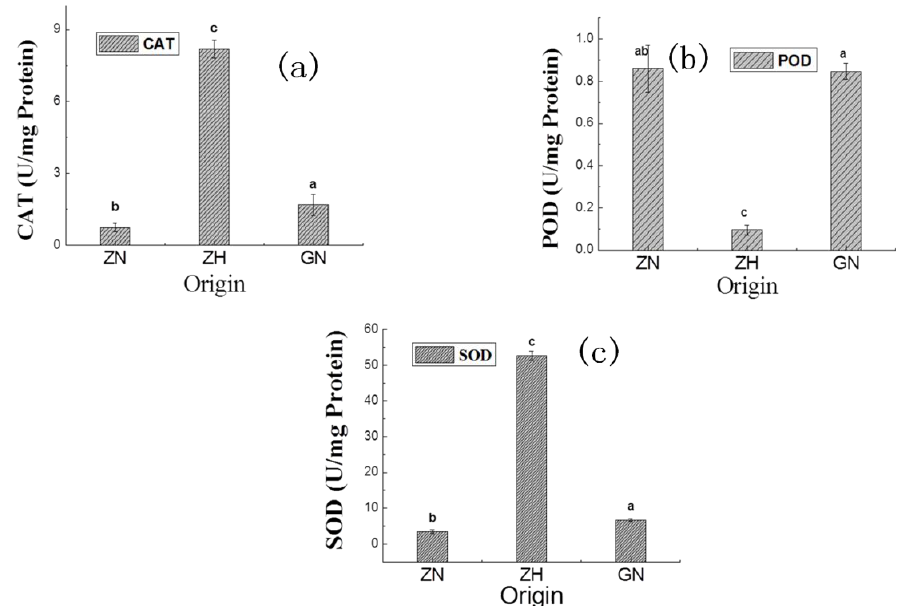
Figure 3. ( a ) Catalase (CAT), ( b ) peroxidase (POD), and ( c ) superoxide dismutase (SOD) enzyme activities of K . obovata seedlings. Different letters indicate significant difference among sources at the same sampling time according to one-way ANOVA at P < 0.05. GN: normal leaves from Zhanjiang, Guangdong; ZH: the half-wilted leaves from Zhoushan, Zhejiang; ZN: the normal leaves from Zhoushan, Zhejiang.